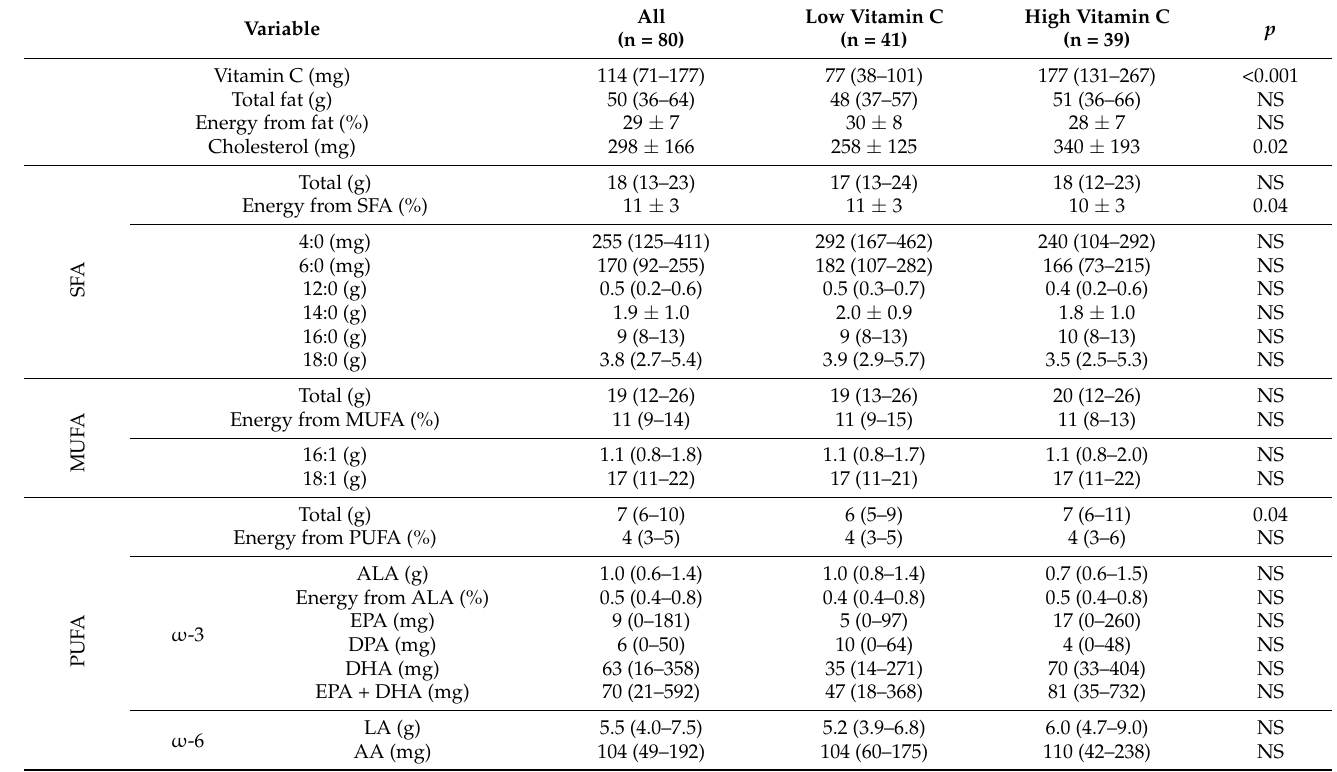
Table 2. Comparison of the daily intake of selected nutrients between the study groups: Vitamin C, fatty acids, cholesterol, and energy from different